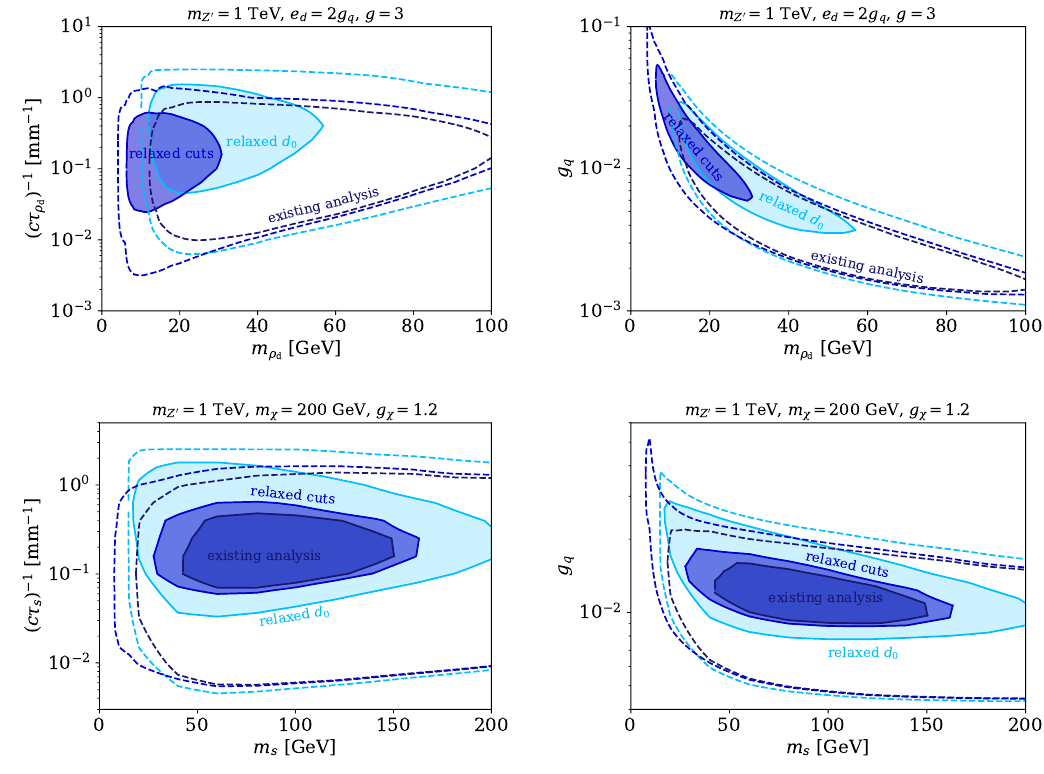
Figure 8 . (Projected) exclusion contours of the existing analysis, the ‘relaxed d 0 ’ analysis, and the ‘relaxed cuts’ analysis for the dark shower model (top) and the dark Higgs model (bottom) shown in the parameter plane spanned by the LLP mass and its inverse lifetime (left) or coupling g Contours for 32.8 fb − 1 integrated luminosity are shown with solid lines, contours for 300 fb − 1 with dashed